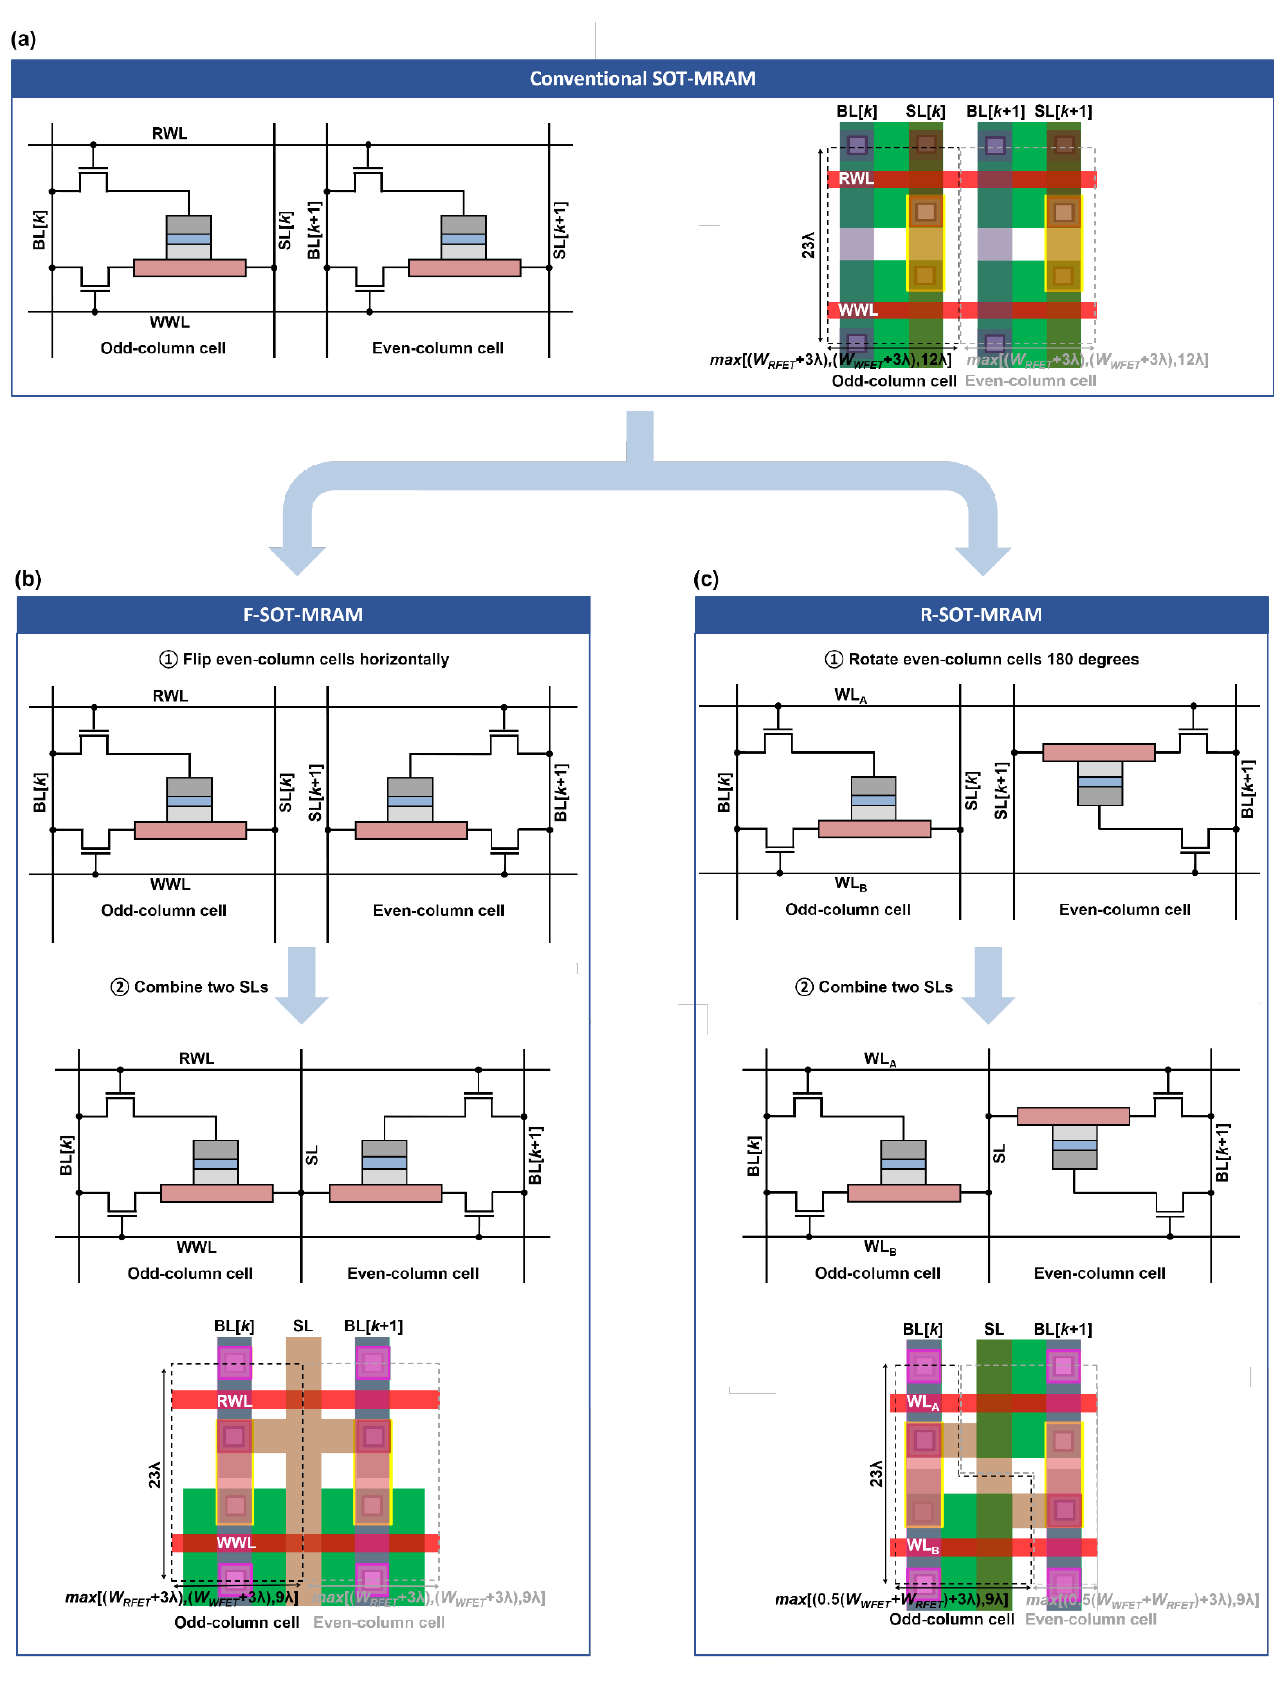
Figure 5. Schematic and layout of ( a ) conventional SOT-MRAM, ( b ) F-SOT-MRAM, and ( c ) R-SOT-MRAM. The second proposed structure, namely, the rotated SOT-MRAM (R-SOT-MRAM), rotates an even-column cell by 180 degrees and combines SLs, as shown in Figure 5c. Note